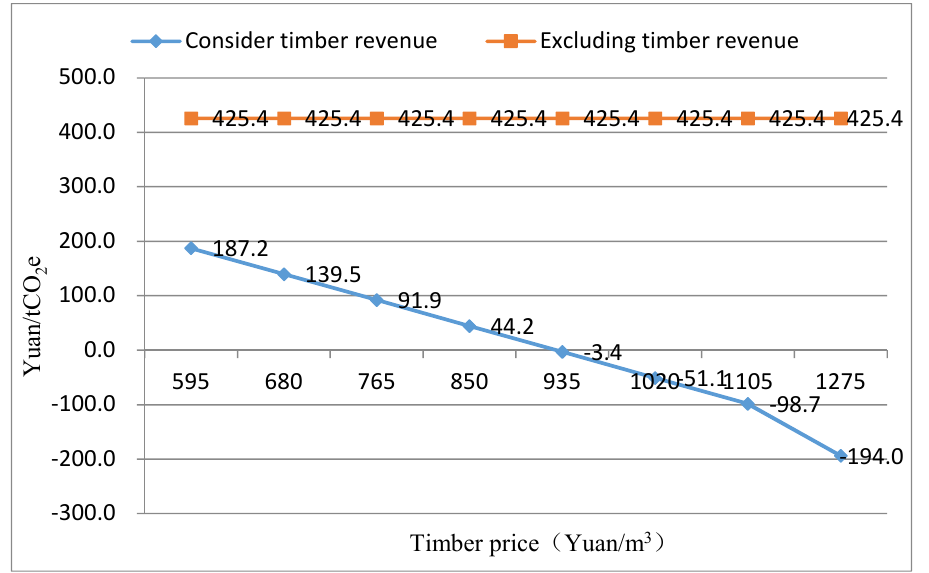
Figure 5. The carbon sequestration cost under different wood prices.